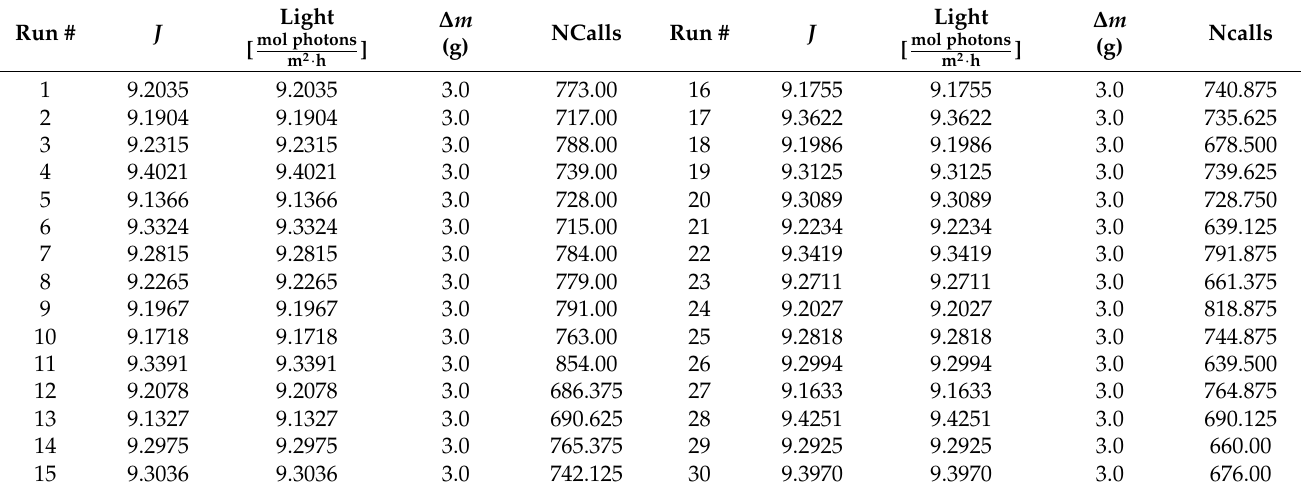
Table 8. Simulation series for RHC_Closed_Loop with SENSOR mode = 1.